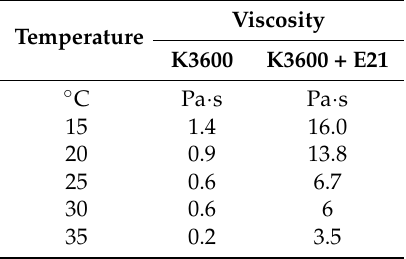
Table 1. Viscosity measurement results for K3600 and K3600 + E21 (10 wt %) systems. Viscosity Temperature